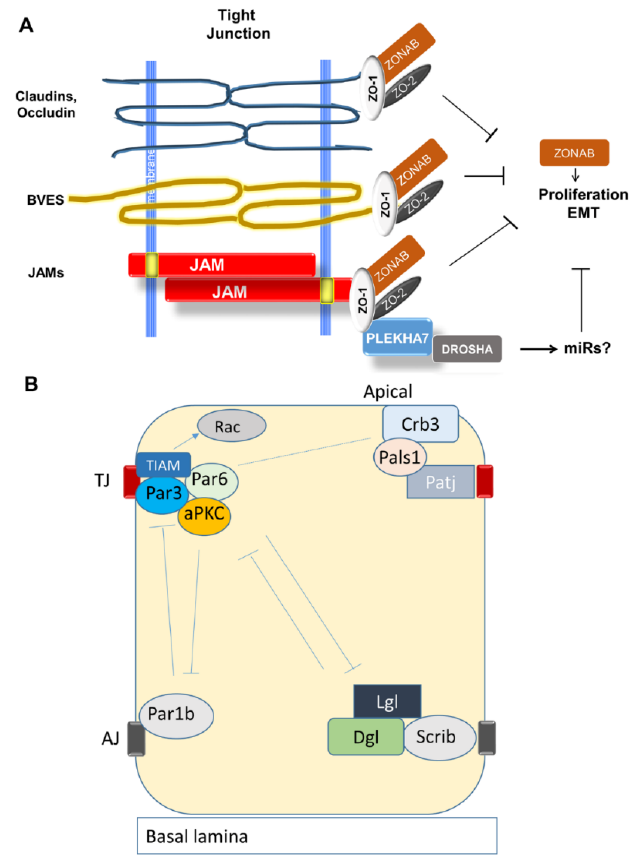
Figure 2. Tight Junctions. ( A ) A simple representation of signaling events at Tight Junctions